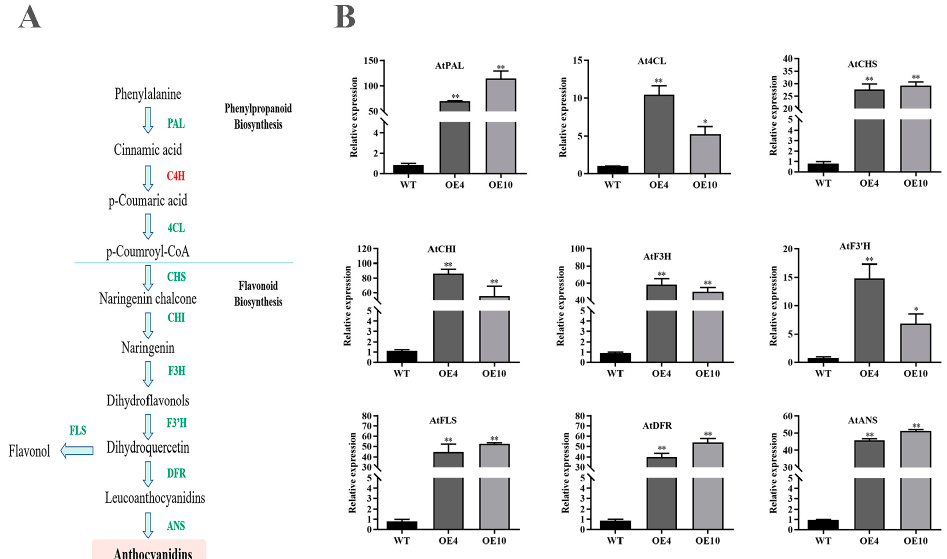
Figure 10. The expression of genes related to flavonoid synthesis pathway in CtC4H OE transgenic lines. ( A ) Schematic diagram of flavonoid synthesis pathway. ( B ) The qRT-PCR analysis of key genes involved in flavonoid biosynthesis (AtPAL, At4CL, AtCHS, AtCHI, AtF3H, AtF3’H, AtFLS, AtDFR, AtANS) in WT and CtC4H1 transgenic plants. The numerical value represents the average ± standard deviation of three biological repetitive samples. The statistics were calculated with one-way ANOVA test and significant differences between treatments were demonstrated with asterisk (* p < 0.05, ** p < 0.01).